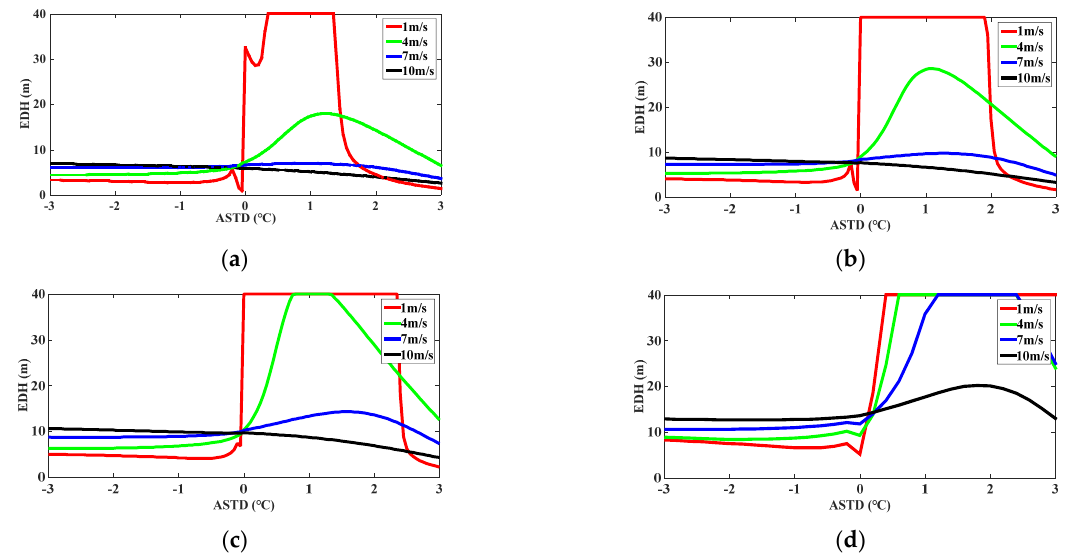
Figure 10. The predicted value of EDH according to the NAF model. The RH was fixed at 80%. The WS of 1 m/s, 4 m/s, 7 m/s, and 10 m/s are represented by the red solid line, green solid line, blue solid line, and black solid line, respectively. The SST was set at 15 °C, 20 °C, 25 °C, and 30 °C according to ( a – d ), respectively.